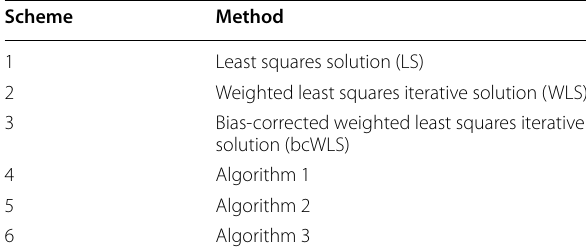
Table 1 Six schemes and their corresponding methods